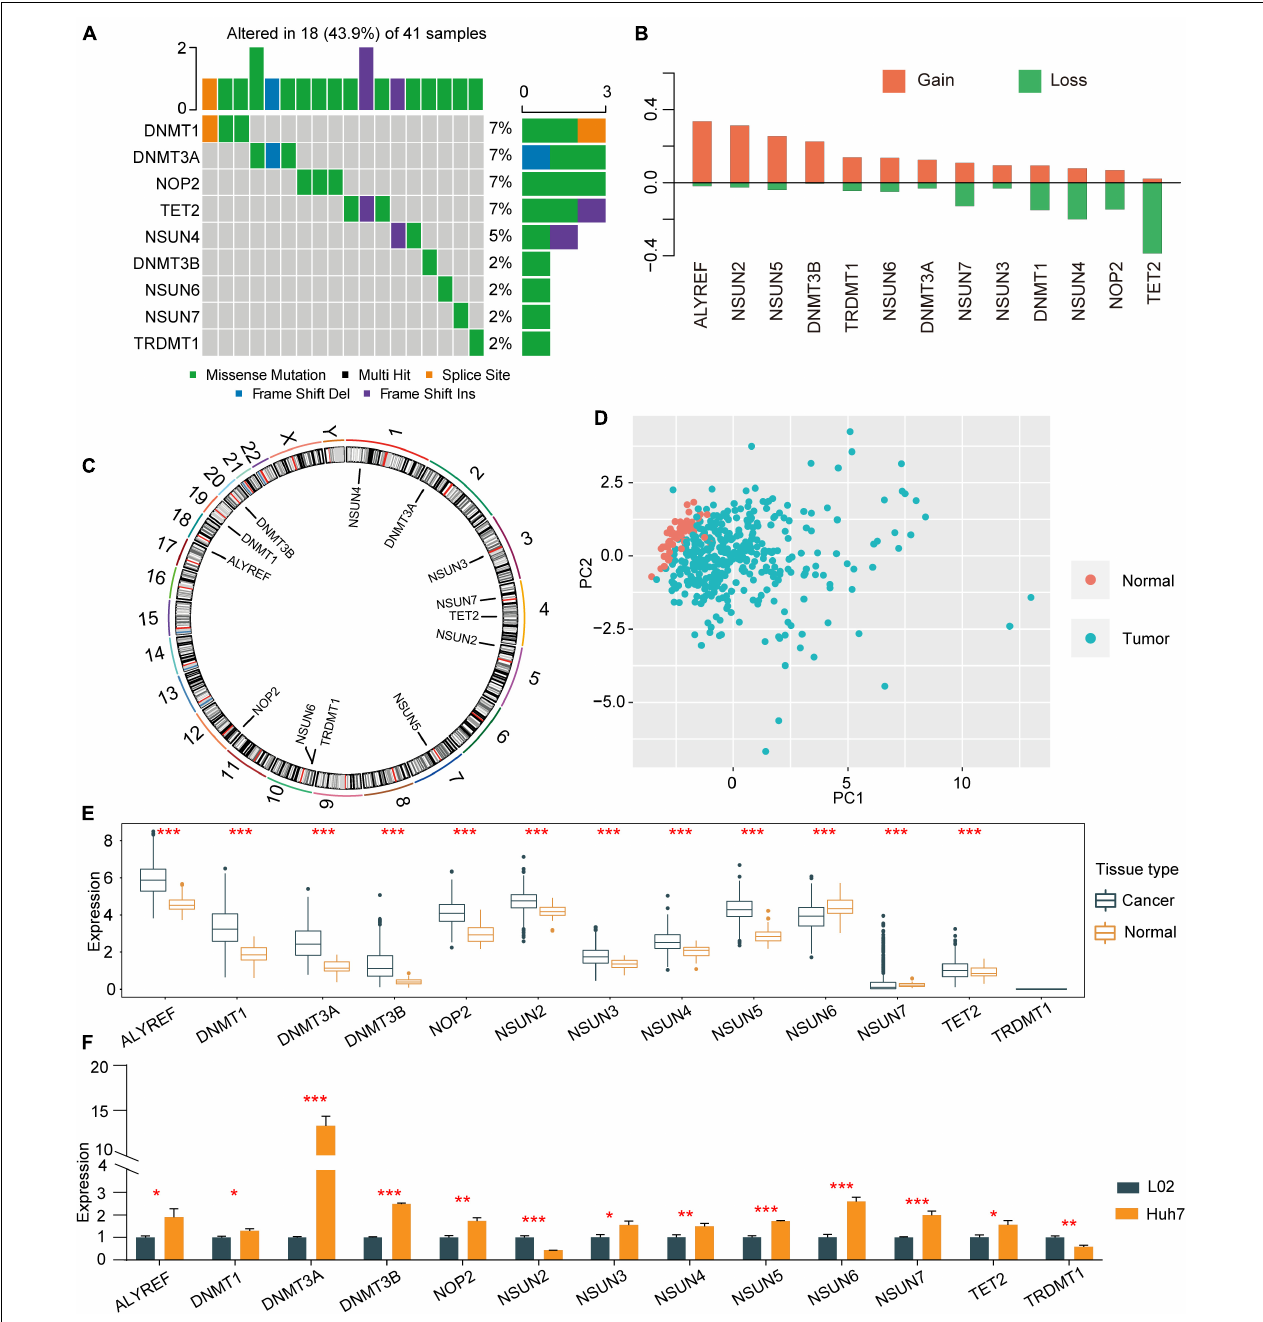
FIGURE 1 | Copy number variations and somatic mutations in 13 m 5 C regulators in HCC. (A) Mutation frequencies of the top 9 m 5 C regulators. (B) CNV alterations among the 13 regulators. (C) Locations of mutations in the m 5 C regulators at the chromosome level. (D) Principal component analysis was used to distinguish tumour tissues and normal tissues based on the expression of m 5 C regulators. (E) The expression profiles of m 5 C regulator genes in tumour tissues and adjacent normal tissues. (F) qRT-PCR was used to determine the relative expression of NOP2, NSUN2, NSUN3, NSUN4, NSUN5, NSUN6, NSUN7, DNMT1, TRDMT1, DNMT3A, DNMT3B, TET2, and ALYREF in HCC cell line Huh7 and normal control cell line L02. * p < 0.05, ** p < 0.01, *** p < 0.001.